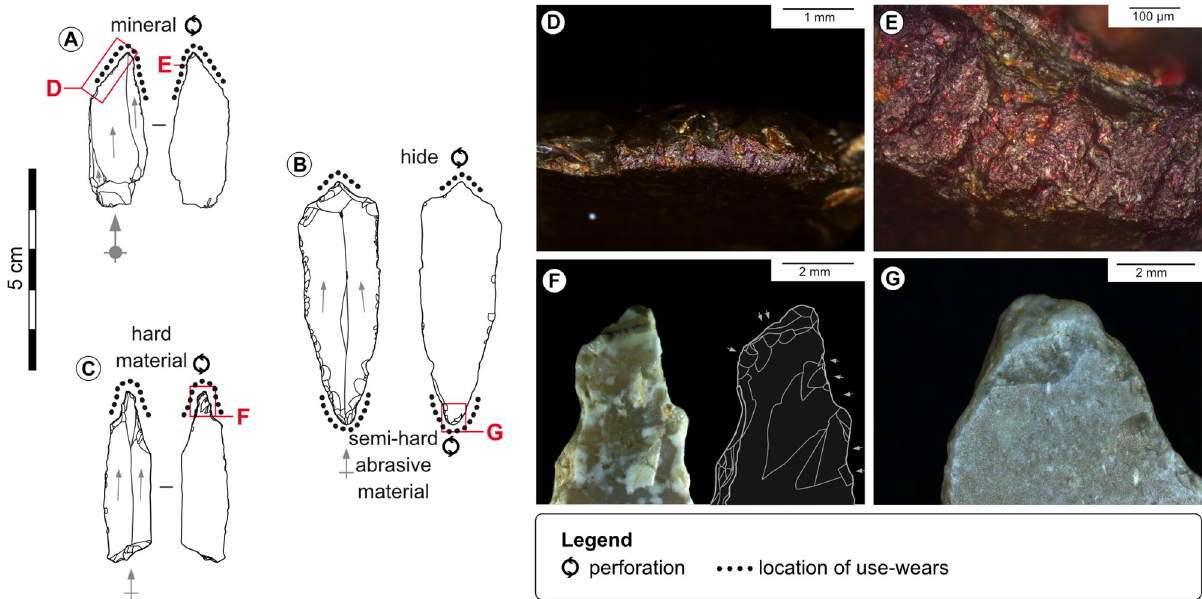
Fig 12. Used beaks and perforators. A-Microperforator from the Blanchard cave, layer B5. B-Double beak from La Marche. C-Microperforator from La Marche. D, E-Wears and residues on the distal point of tool n˚A due to perforating a colouring mineral with particularly thick abrasive particles, credits: Gauvrit Roux, 2019. F-Scars due to perforating a hard material with the tip of tool n˚C. G-Rounding and scars due to perforating a semi-hard abrasive material on the proximal tip of tool n˚B.